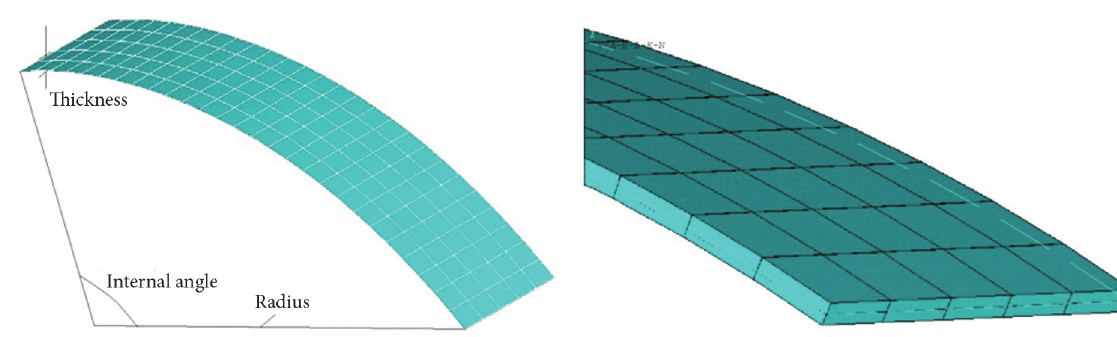
Fig. 4. An isometric view of the structure and the shape of the element